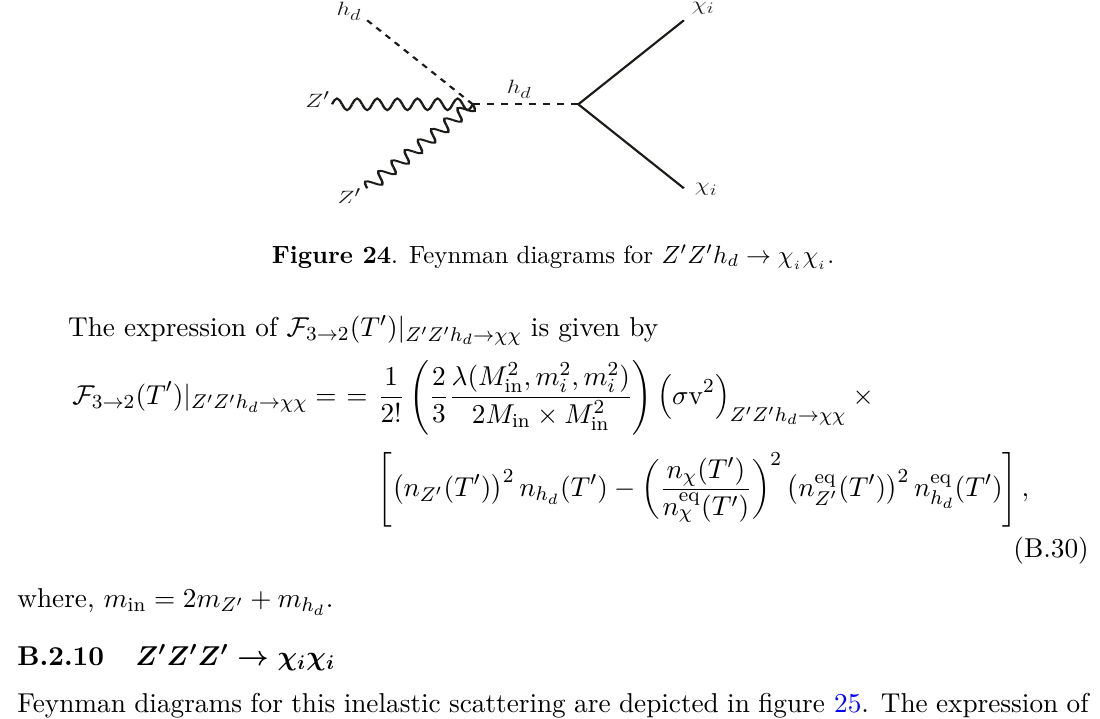
Figure 24 . Feynman diagrams for Z 0 Z 0 h d → χ